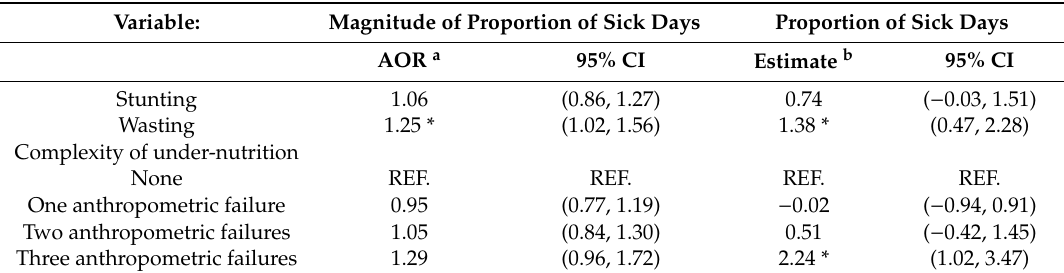
Table 3. The impact of nutritional status on the proportion of sick days experienced in the next period by calculated adjusted odds ratios (AORs) and fitted estimates of mixed-e ff ect